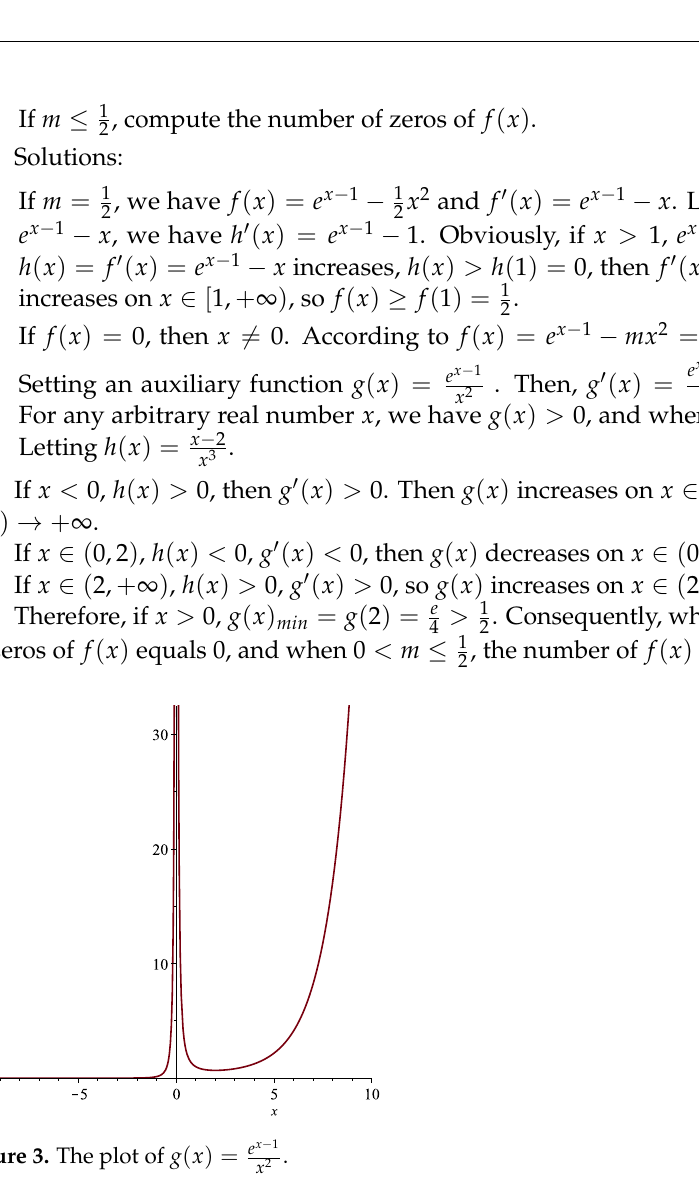
Figure 3. The plot of g ( x ) = e x − 1